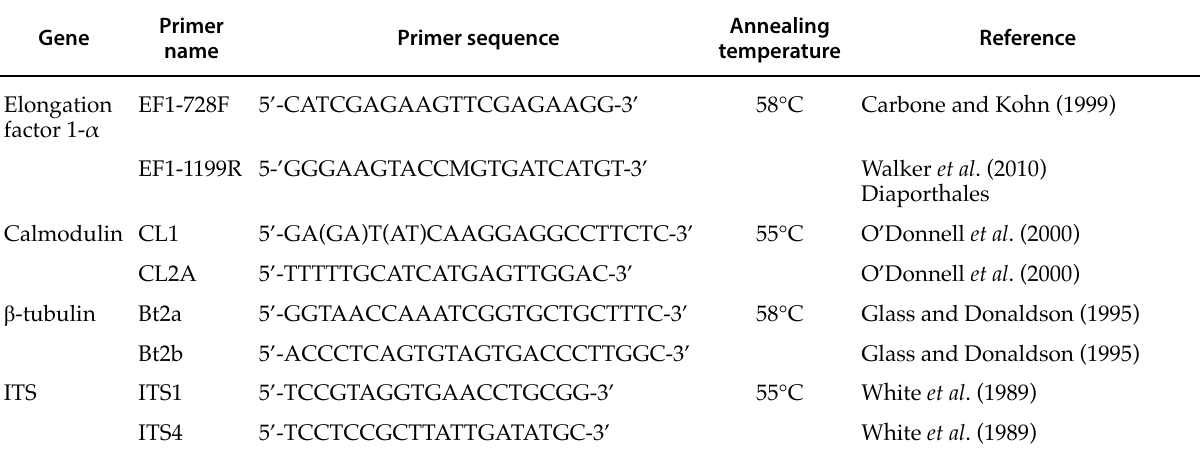
Table 2. Primers and annealing temperatures for PCR reactions used in this study.